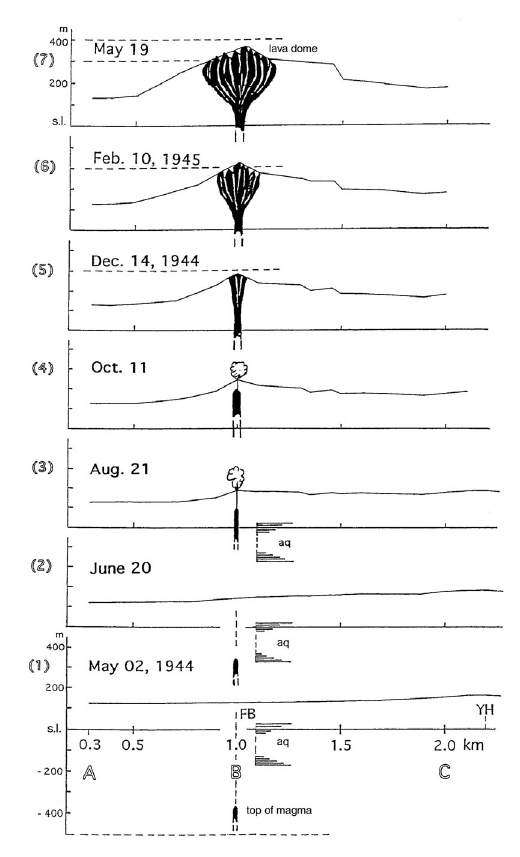
Fig. 8. Pseudo growth curves of the 1944 dome. The benchmarks on the abscissa are distributed at an in- terval of approximately 100 m as the same as fig. 6. Explosion activity was high between survey nos. 2 and 3. aq – aquifer; FB – Fukaba; YH –